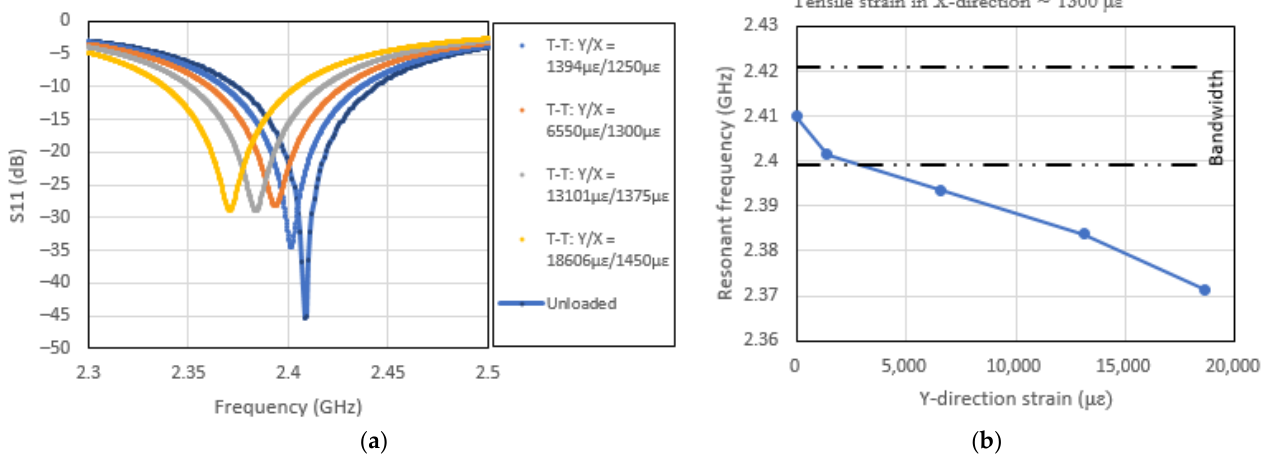
Figure 12. ( a ) Effects of bi-axial loading (tension–tension) on patch antenna’s S11 (Loading Case 1) and ( b ) resonant frequency excursion with respect to the CLAS bandwidth under bi-axial loading (tension–tension).